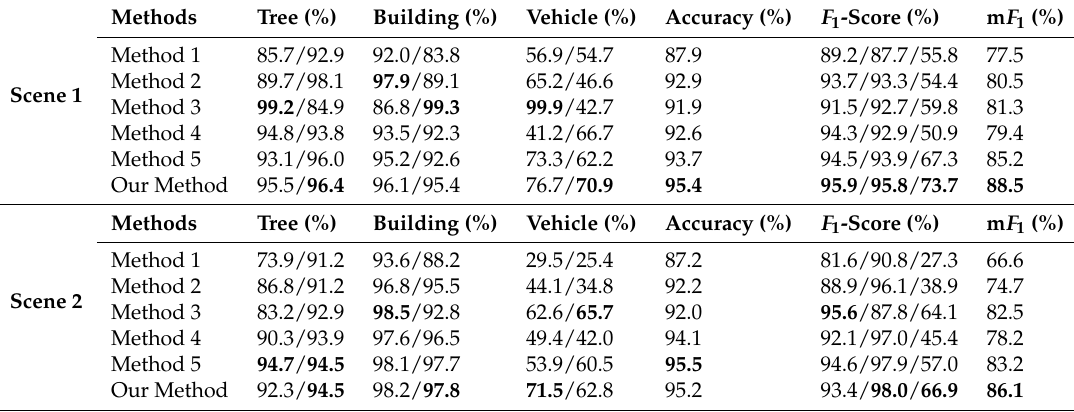
Table 4. Quantitative comparison of six classification methods using measures of “precision/recall”, “accuracy”, “ F 1 -score”, and “m F 1 ”. The values from columns of tree, building, and vehicle correspond to “precision/recall”. The measure of “accuracy” means the overall performance of three classes. The values of “ F 1 -score” correspond to tree, building, and vehicle. The last column represents the value of “m F 1 ” measure, which is calculated by averaging the three classes.